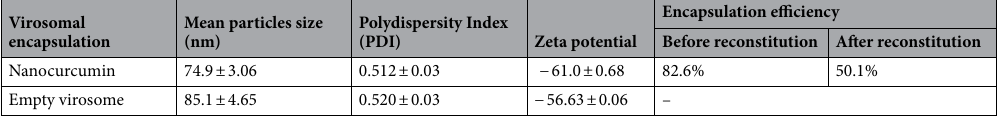
Table 2. Encapsulation efficiency of the influenza